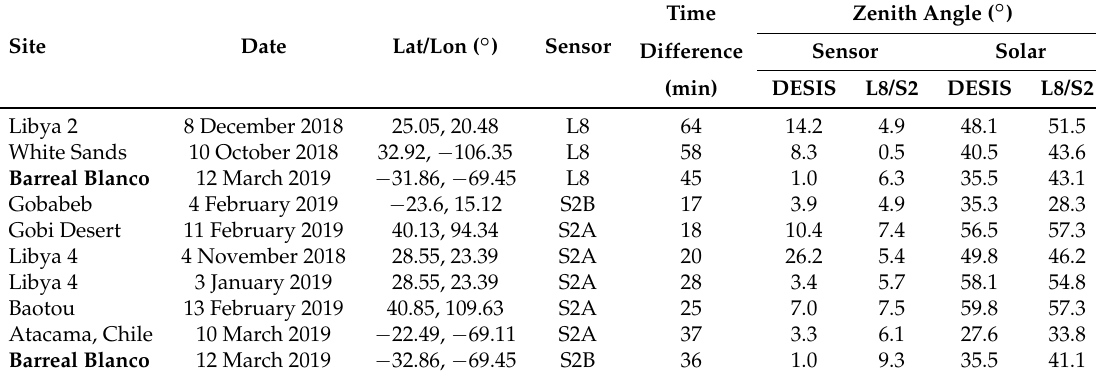
Table 5. Near-coincident DESIS and Landsat-8 or Sentinel-2 acquisition